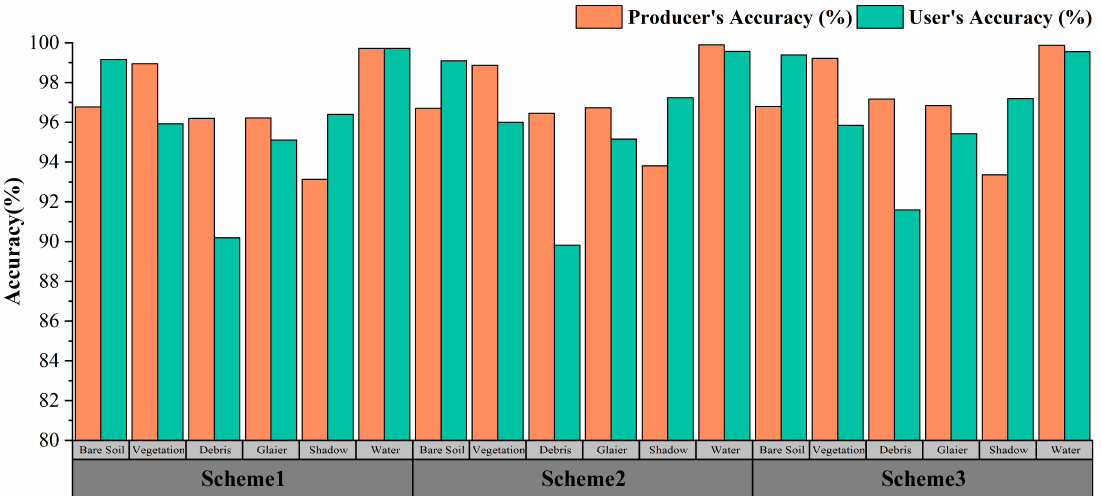
Figure 10. Accuracy assessment of land cover classification